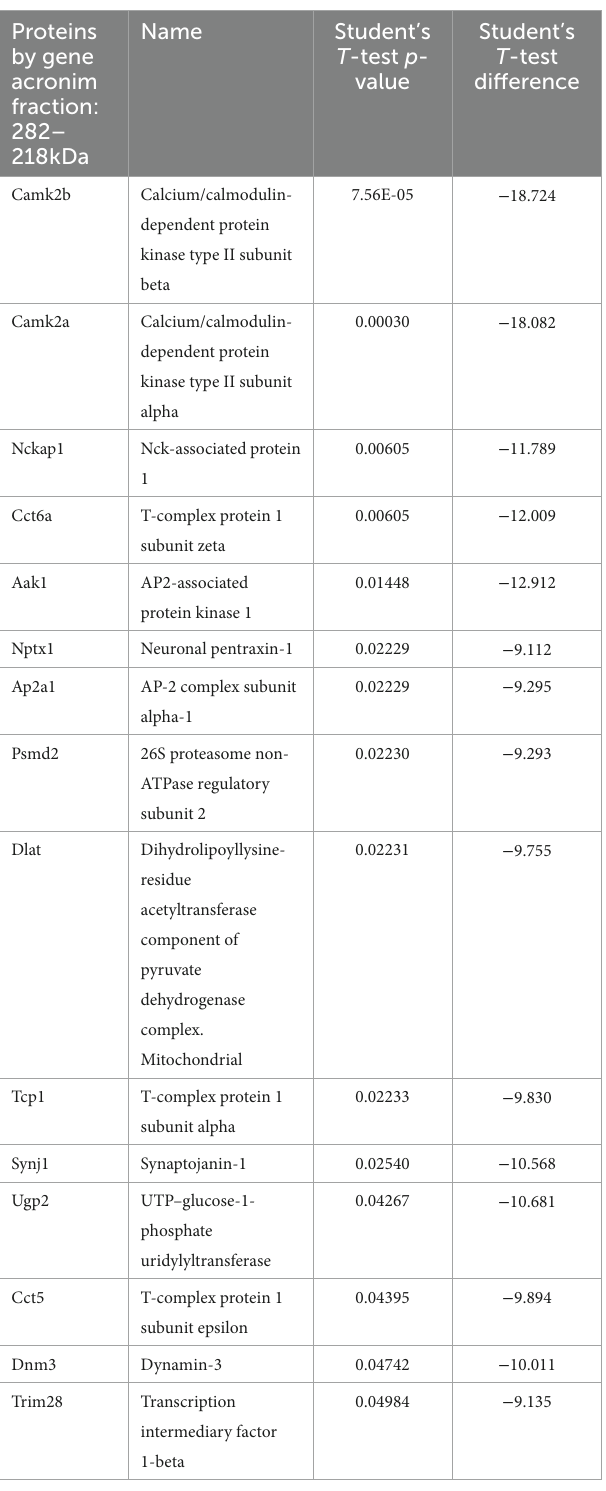
TABLE 2 Proteins with altered levels in Ki150 fractions 115–89 kDa positive for ataxin-3 protein compared to Ki21